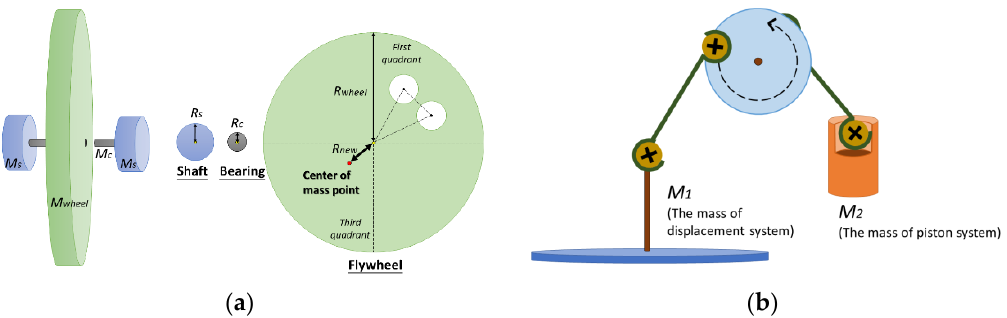
Figure 4. Nomenclature and major components of flywheel power systems. ( a ) The shafts, bearing, and flywheel; ( b ) The M 1 and M 2